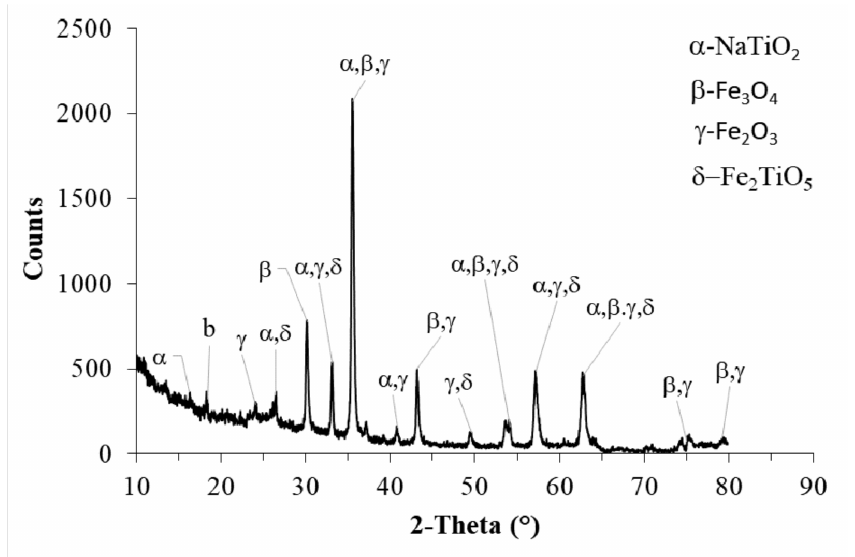
Figure 9. X-ray diffractogram of fly ash from ESP after combustion of coal in a pulverized fuel boiler. The XRD results show that the dominant phase is magnetite Fe 3 O 4 and maghemite γ - Fe 2 O 3 (with a considerable amount of Fe-spinel enriched by Na and Ti elements, cf. Figure